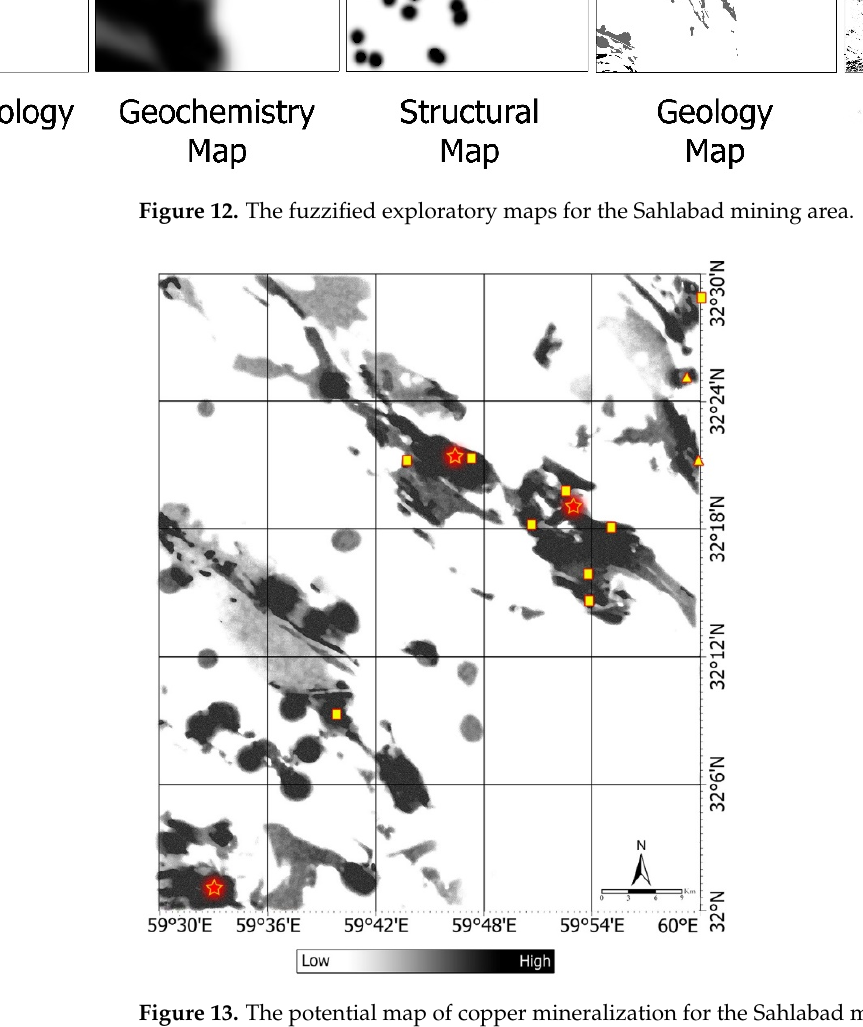
Figure 13. The potential map of copper mineralization for the Sahlabad mining area.